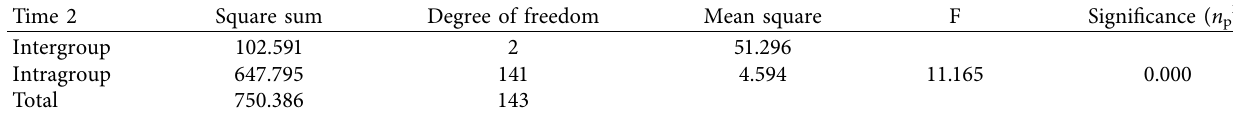
Table 3: Experimental data analysis results of time 2.